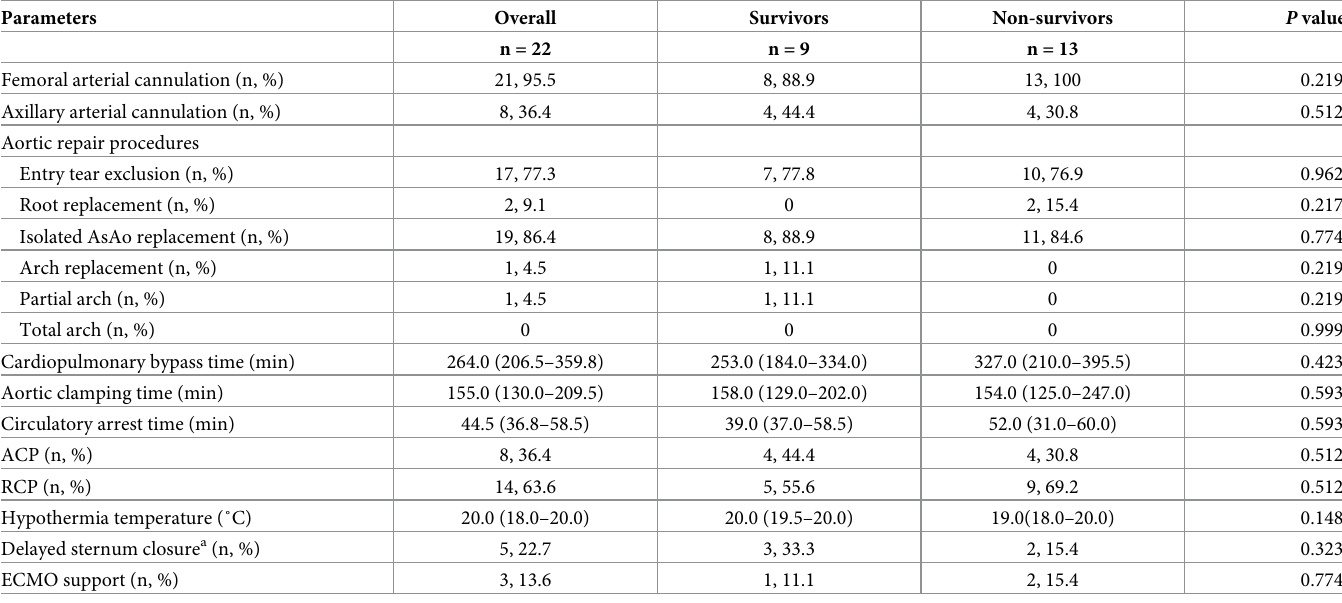
Table 3. Surgical information according to patient